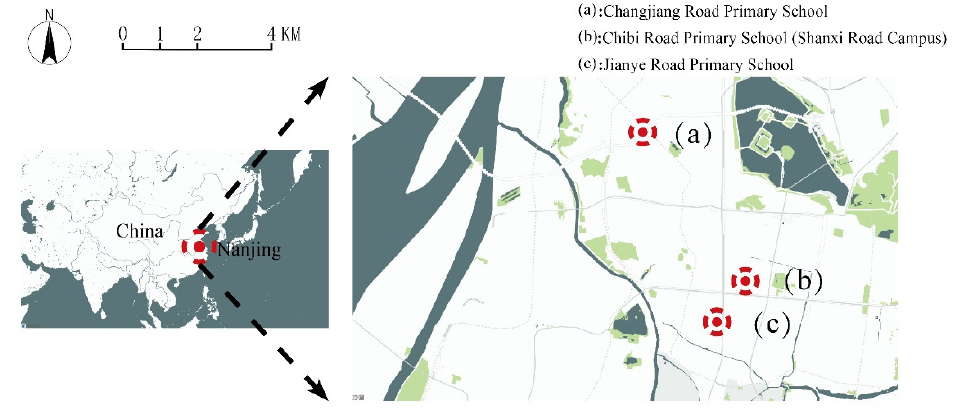
Figure 1. Location of three schools in Nanjing. Table 1. Characteristics of three schools.